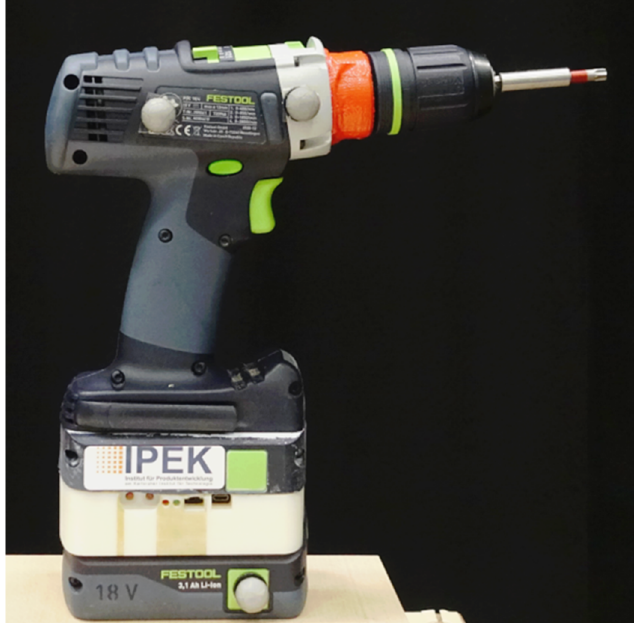
Figure 1. Festool screwdriver. Datalogger was placed in the screwdriver’s battery interface to record the electric current and voltage during the tasks.